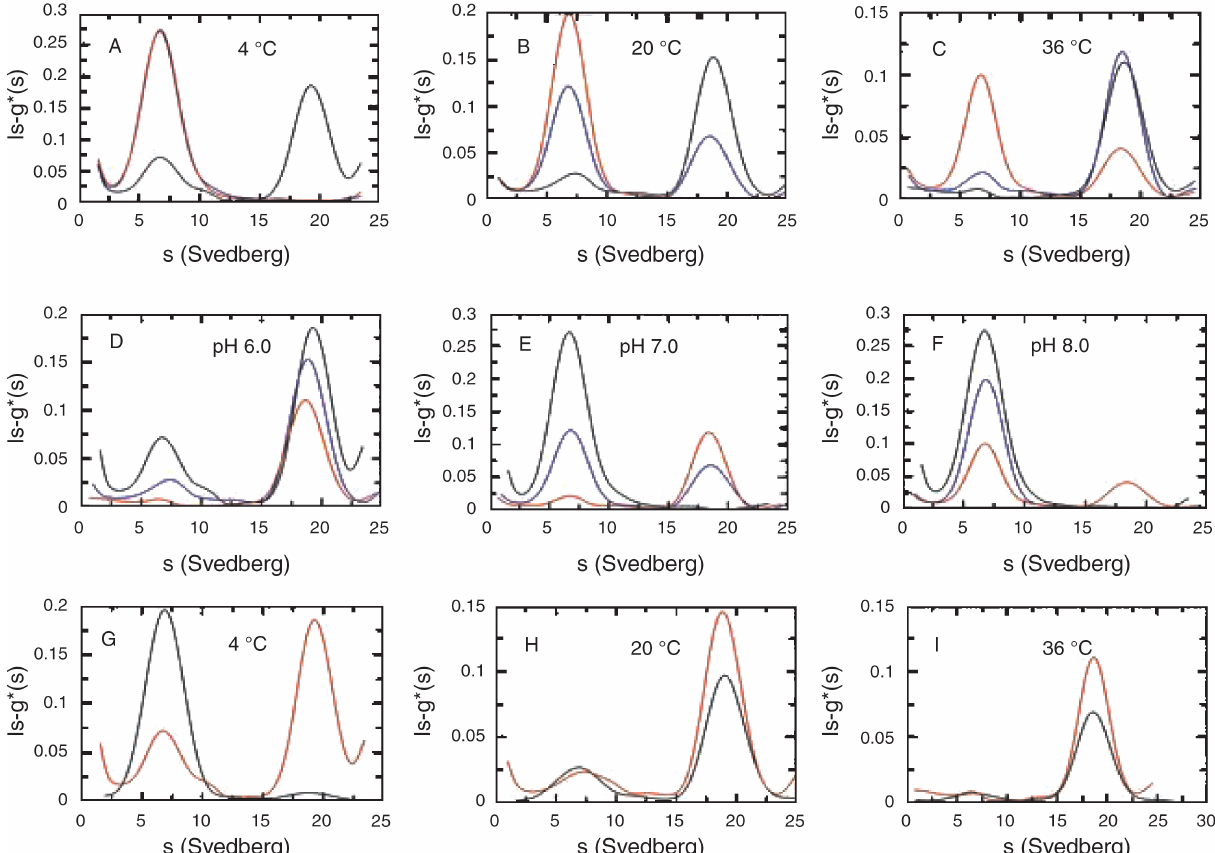
Figure 2. The pH, temperature and salt dependence of the Sulfolobus solfataricus recombinant WT amidase oligomerization process assessed by analytical centrifugation. Experiments were conducted at 117,000 g after overnight incubation at about 0.5 mg ml –1 at the indicated pH and tem- perature. Each trace refers to a different experiment. Experiments conducted at 4 (A), 20 (B) and 36 (C) °C in 20 mM sodium phosphate pH 6.0 (black), 7.0 (blue) and 8.0 (red). Experiments conducted in 20 mM sodium phosphate pH 6.0 (D), 7.0 (E) and 8.0 (F) at 4 (black), 20 (blue), and 36°C (red). Experiments conducted at 4 (G), 20 (H), and 36°C (I) in 20 mM sodium phosphate pH 6.0 in the presence (black) or in the absence (red) of 1 M NaCl.